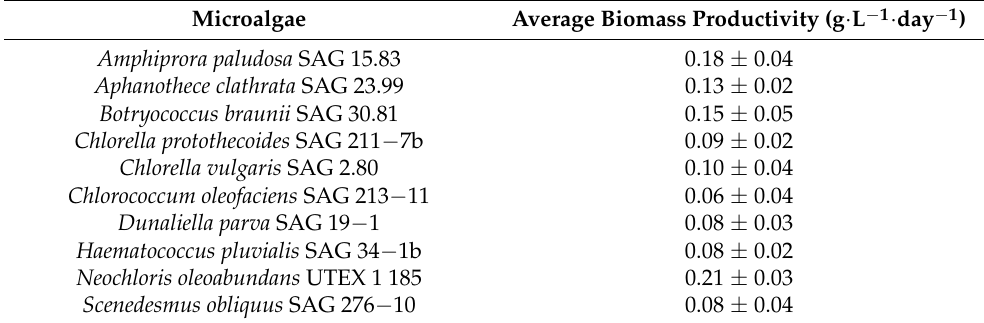
Table 2. Biomass productivities of 10 microalgae cultivated in diluted cassava wastewater (10%). The lipid content is estimated from the C/N mass ratio.